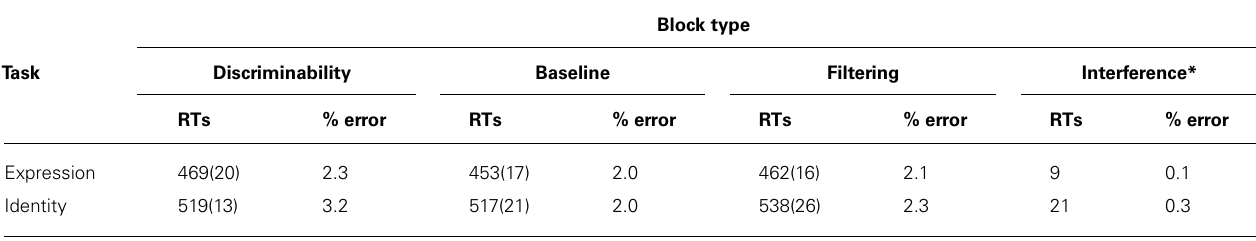
Table 2 | Mean reaction times (in milliseconds), standard errors (in parentheses), and percentages of error of performance in both identity- and expression-judgment tasks during discriminability assessment and interference measurements of Experiment